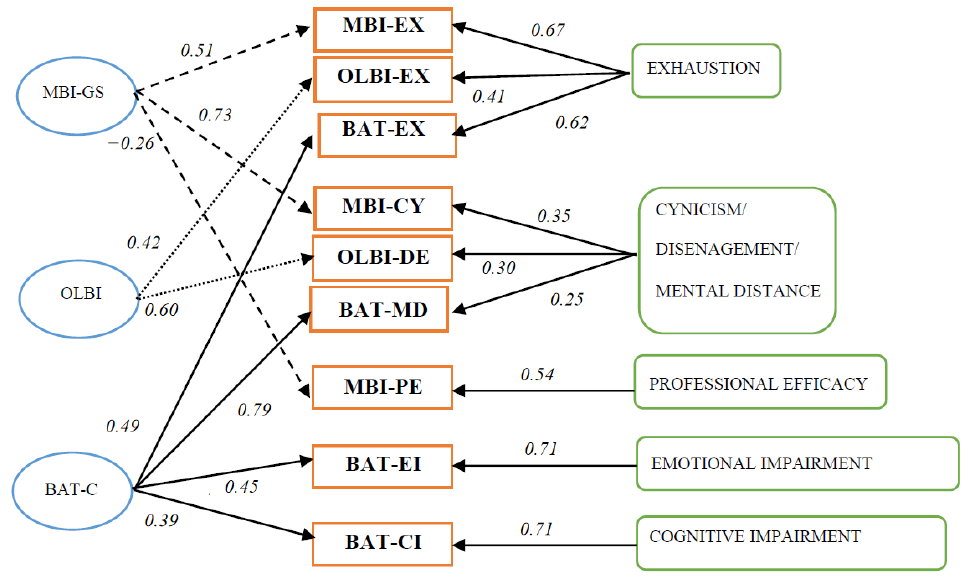
Figure 1. Multi-trait, multi-method framework for the Burnout Assessment Tool—Core (BAT-C), Maslach Burnout Inventory-General Survey (MBI-GS), and Oldenburg Burnout Inventory (OLBI) (correlated traits–correlated methods (CT-CM) model) with average pad coefficients.